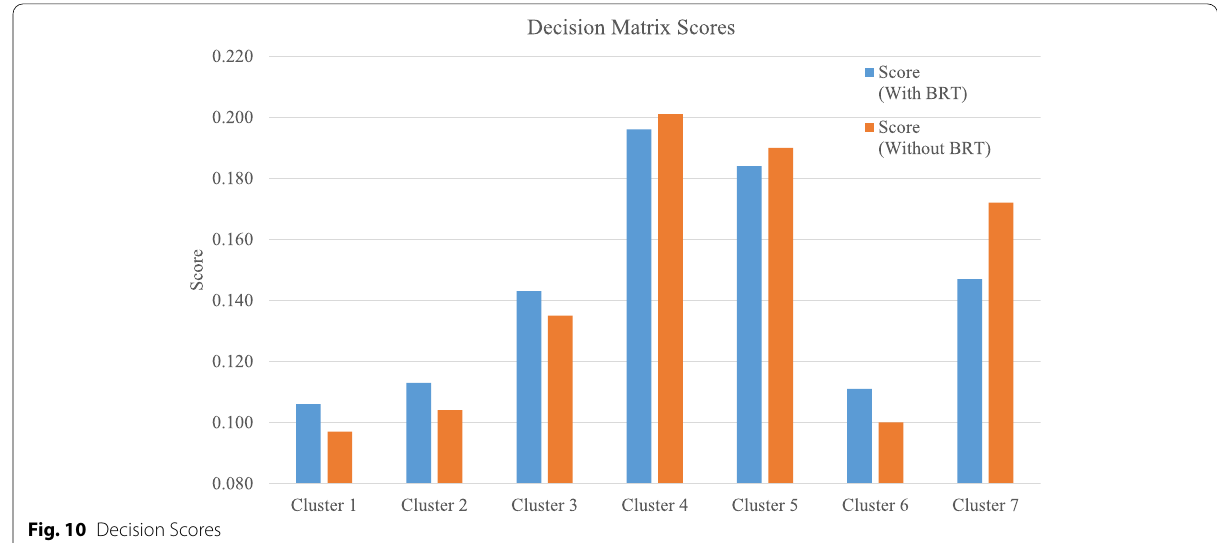
Fig. 10 Decision